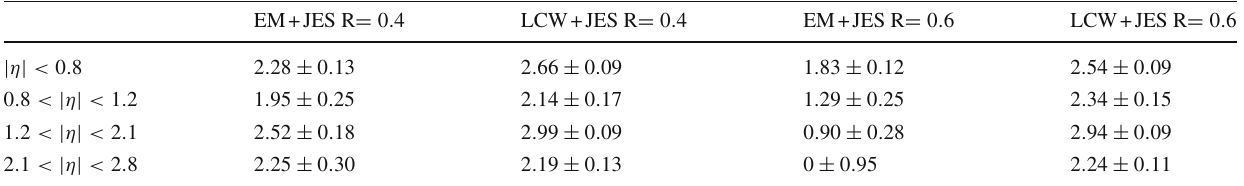
Table 5 The noise term N μ = 0 in GeV extracted in a dijet MC sample without pile-up. The values and uncertainties are extracted from a fit. For data, an additional 20% uncertainty is assigned, based on the 2010 measurements [7] EM+JES R = 0 . 4 LCW+JES R = 0 . 4 EM+JES R = 0 . 6 LCW+JES R = 0 .